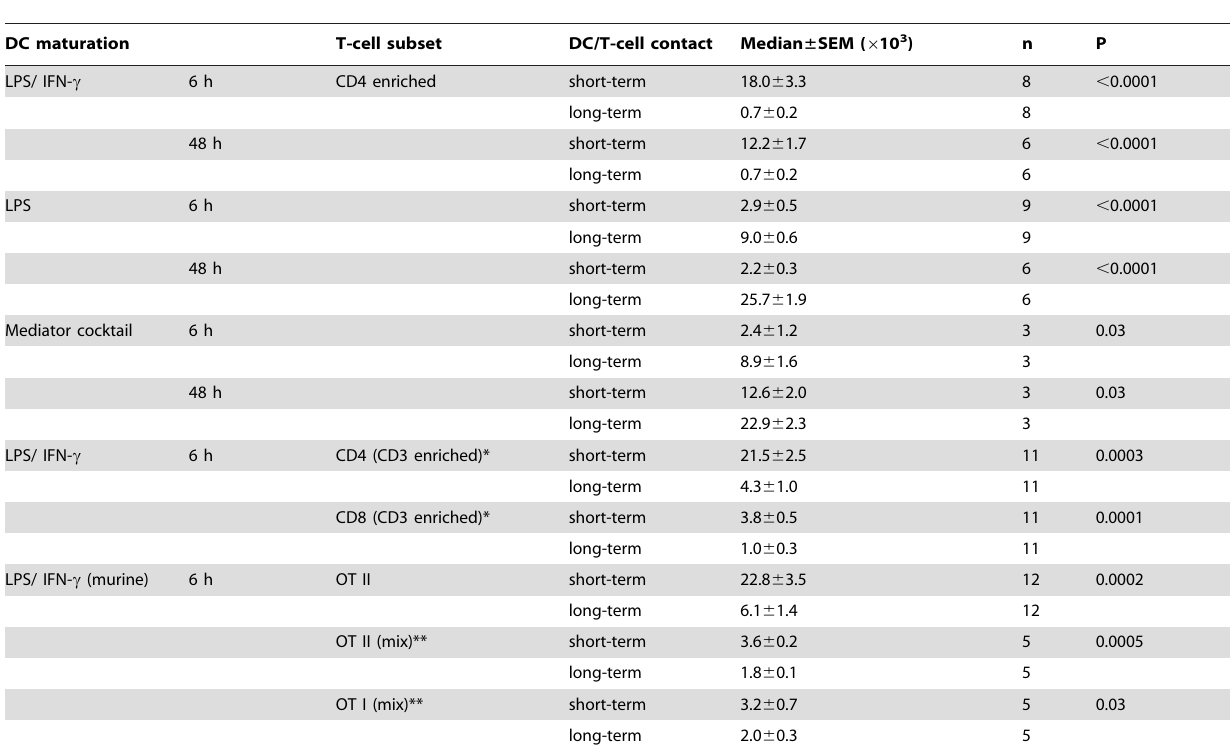
Table 3. Total cell count of proliferated T-cells after short-term or long-term contact with differently stimulated DCs.